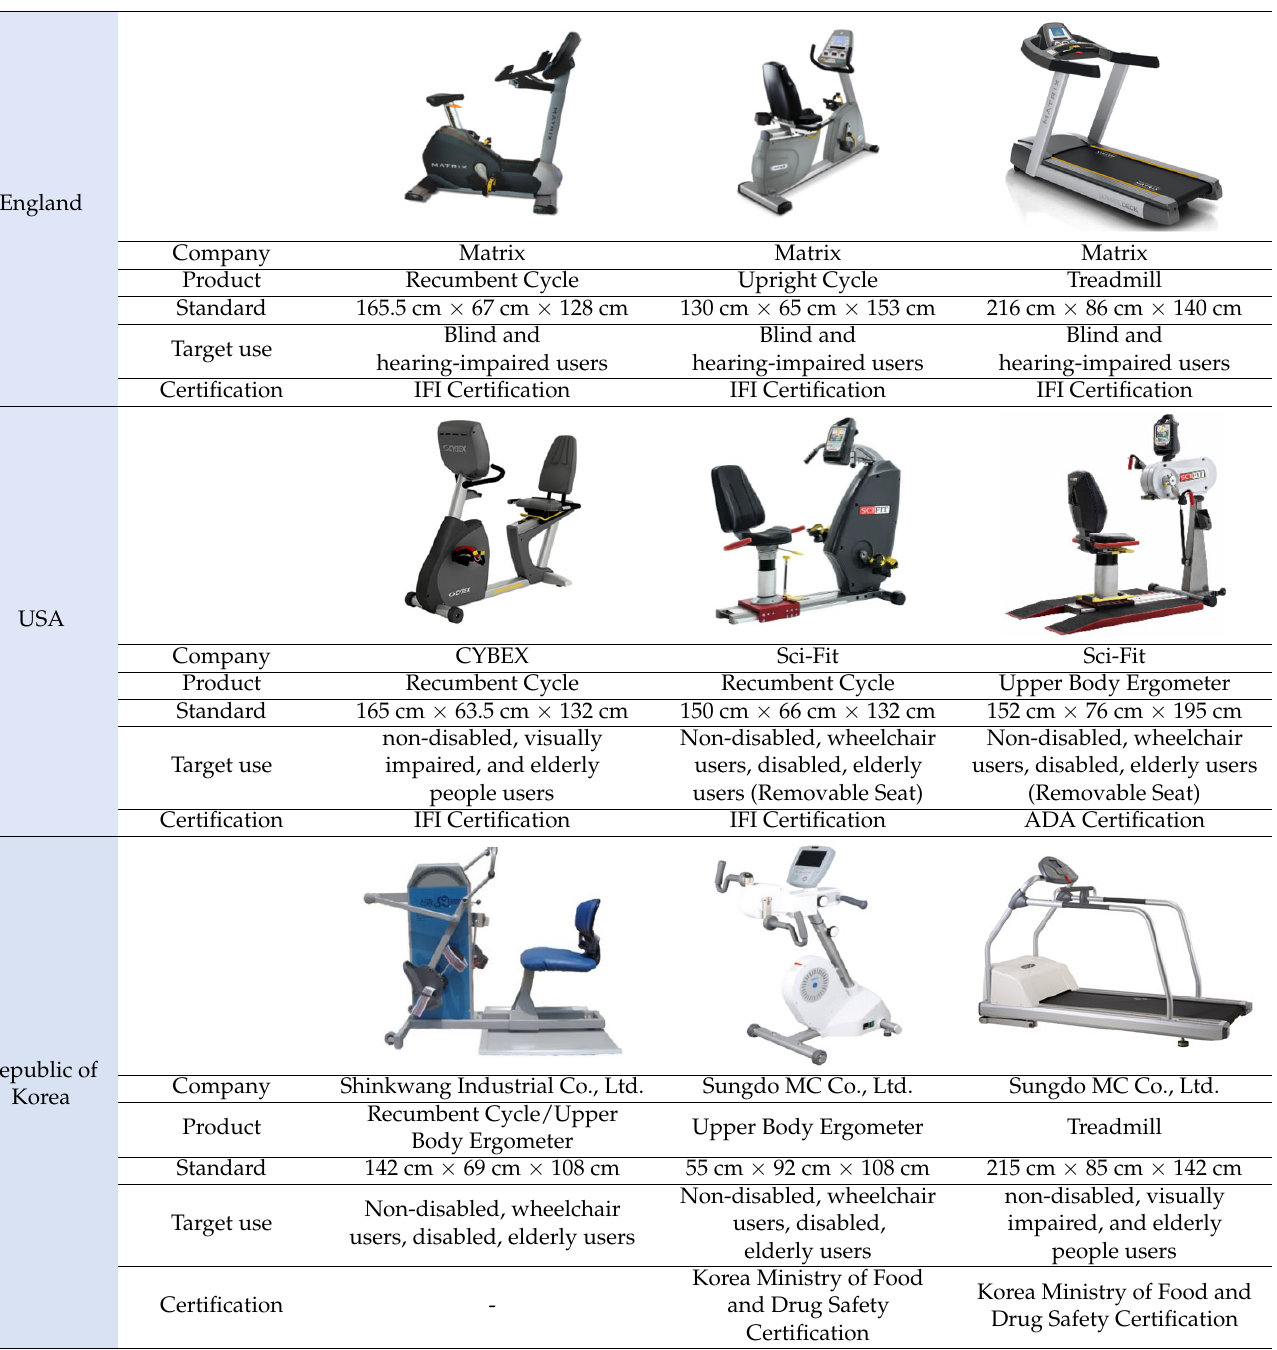
Table 5. Aerobic exercise equipment used by both people with a disability and those with no disability.